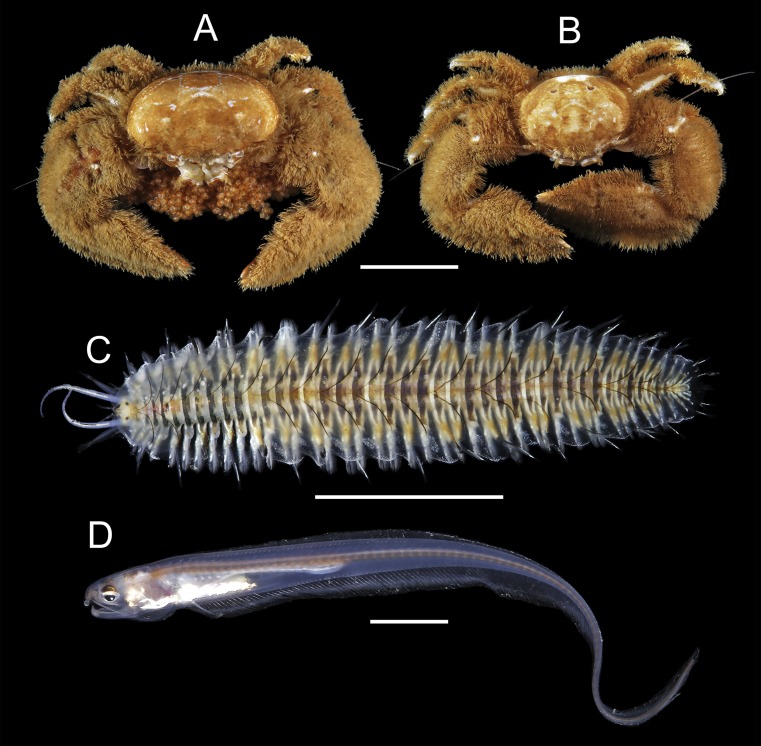
Symbiotic species associated with Chaetopterus cf. appendiculatus: (A, B) Eulenaios cometes (female and male, respectively); (C) Ophthalmonoe pettibonneae; (D) Onuxodon fowleri.Scale bars are 1  cm.